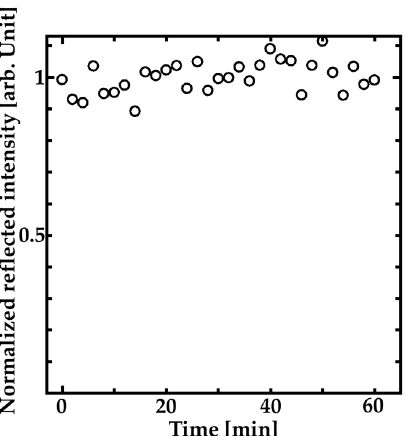
Figure 8. Time dependence of the reflection peak intensity of the fabricated HCG surrounded pure water.